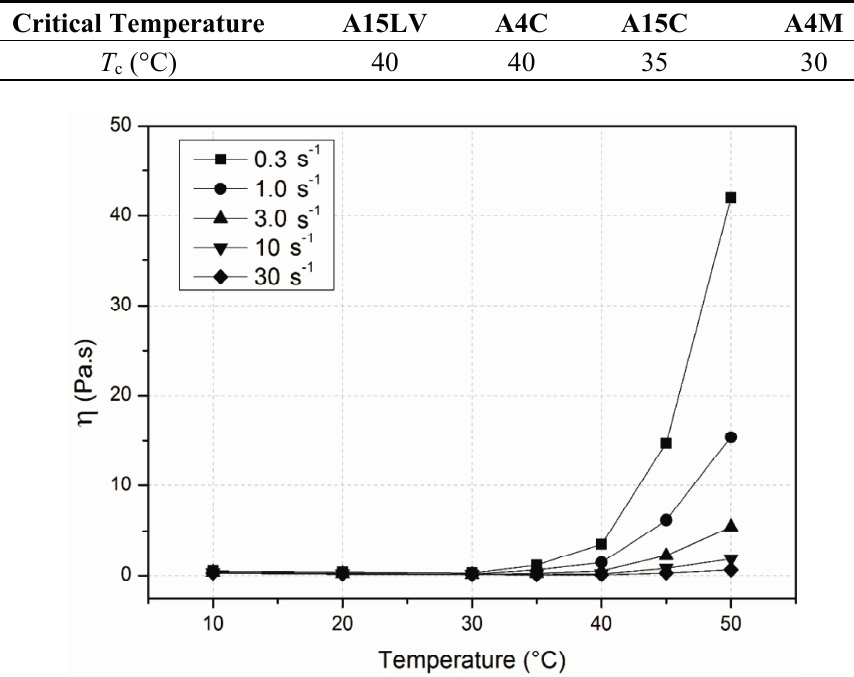
Figure 6. Influence of temperature on the viscosity of methylcellulose solution at different shear rates. Viscosities of a 10 g/L solution of A4M obtained using Cox–Merz transformation of dynamic measurements in the linear viscoelastic region. The lines are added to guide the eye